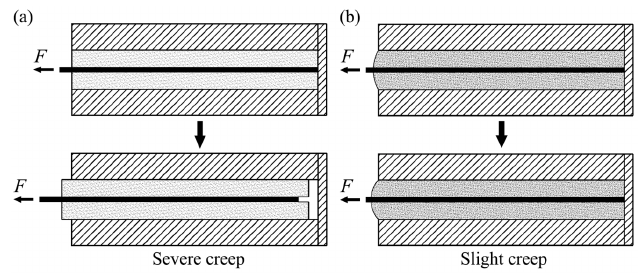
Figure 22. Principle of Highly Expansive Material Filling Anchorage: ( a ) straight tube anchorage with normal mortar and ( b ) Highly Expansive Material Filling Anchorage.